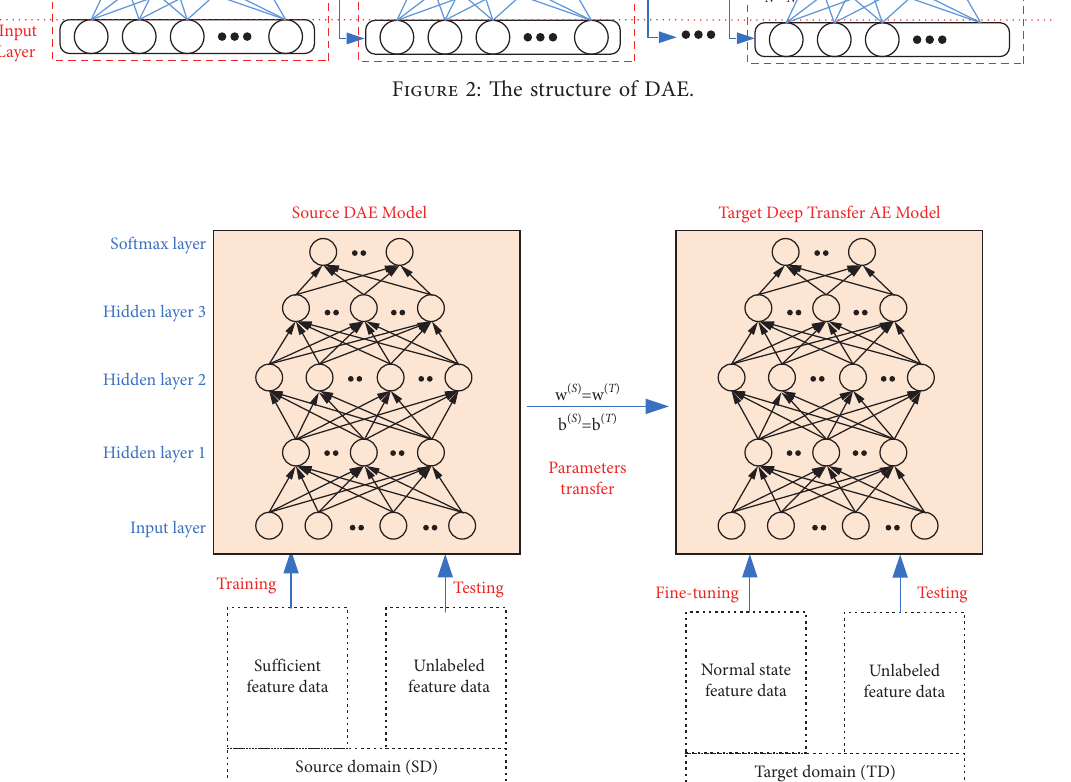
Figure 3: The mechanism of the DTAE